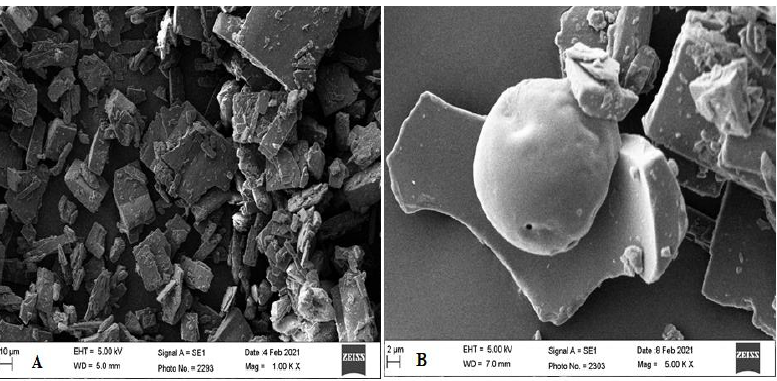
Figure 8. NMR spectra of pure Genistein (GS), genistein ternary mixture (GS-TM) and genistein ternary complex (GS-TC).